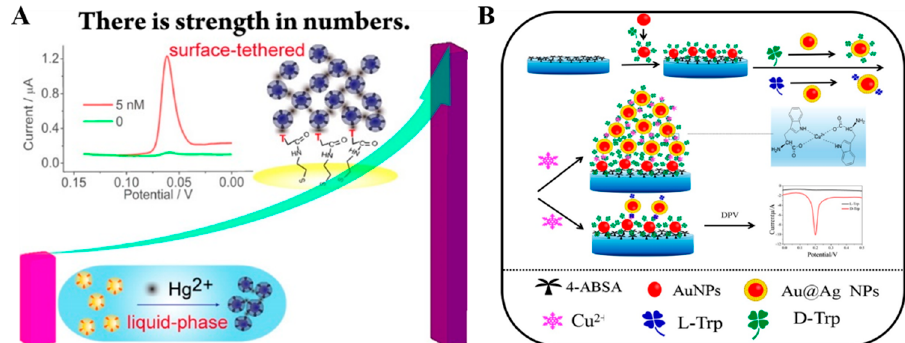
Figure 4. ( A ) Schematic representation of the electrochemical Hg 2+ sensor based on Ag-T nanoprobes [28]. Copyright 2015 American Chemical Society. ( B ) Schematic representation of electroactive Au@Ag NP assembly driven signal amplification for ultrasensitive chiral discrimination of D-/L-Trp [59]. Copyright 2019 American Chemical